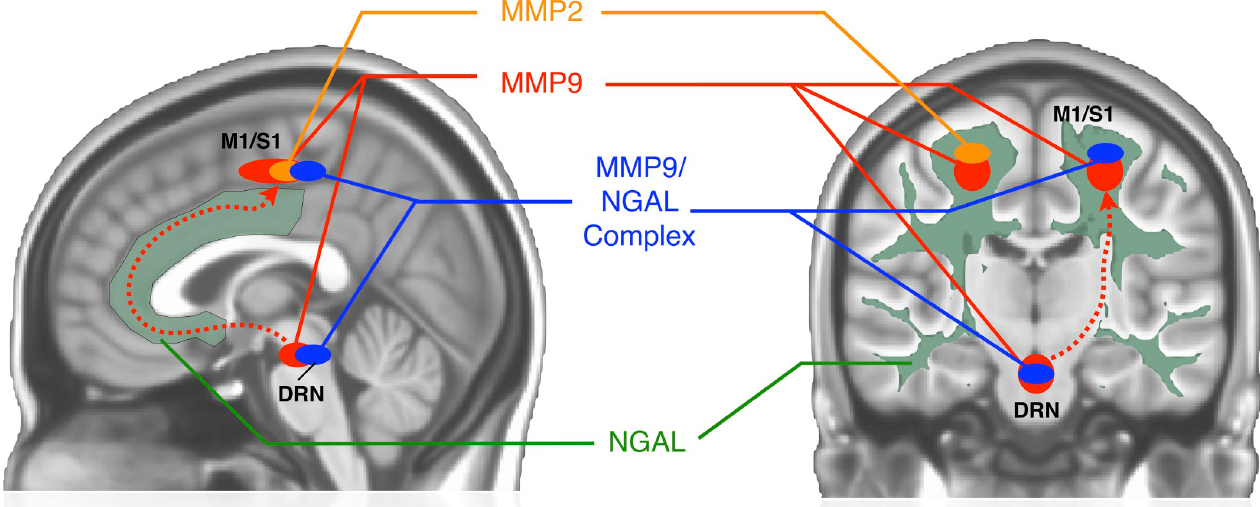
Fig 6. Illustration of observed associations between urinary protein levels and DTI brain measures. In UCPPS patients with elevated MMP9 as a result of local or systemic inflammation, excitotoxicity and eventual death of neurons in the dorsal Raphe nuclei (DRN) may occur, as MMP9 is known to lead to excitotoxicity in glutamatergic neurons and 2/3 of neurons in the DRN are both glutamatergic and serotonergic. The DRN is known to be the primary serotonergic center for the brain and projects throughout the brain including sensorimotor (M1/S1) regions. Increased concentration of MMP9, NGAL, MMP9/NGAL complex, and altered serotonin all modulate aspects of brain plasticity through manipulation of dendritic projections, altering long-term potentiation (LTP), and other synaptic changes. Additionally, altered serotonin levels, MMP9, and NGAL have all independently been linked to other conditions including anxiety and depression, which are also commonly observed in patients with